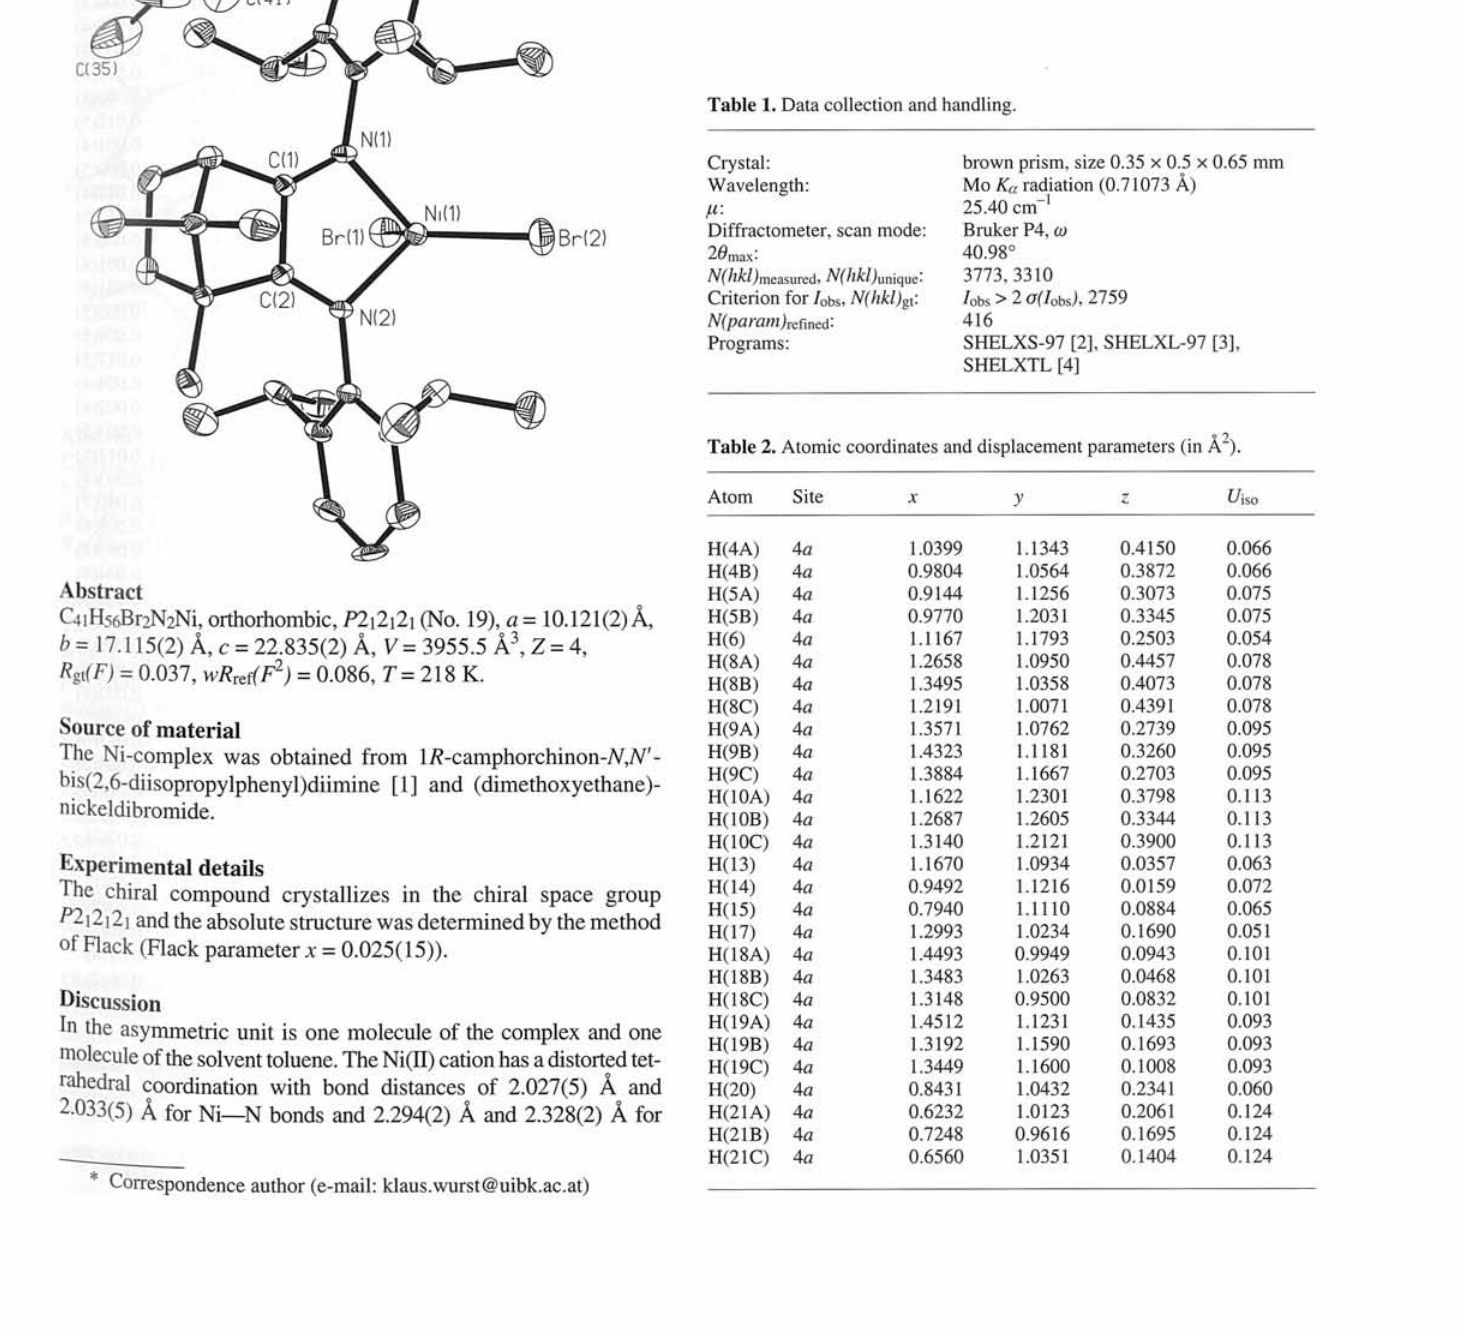
Table 1. Data collection and handling.